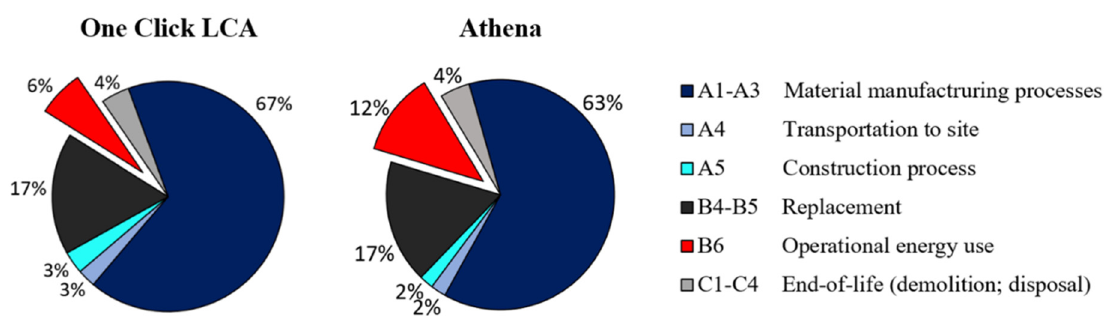
Figure 6. Emissions contribution of each life cycle stage for FBL’s baseline scenario (A to C), using One Click LCA and